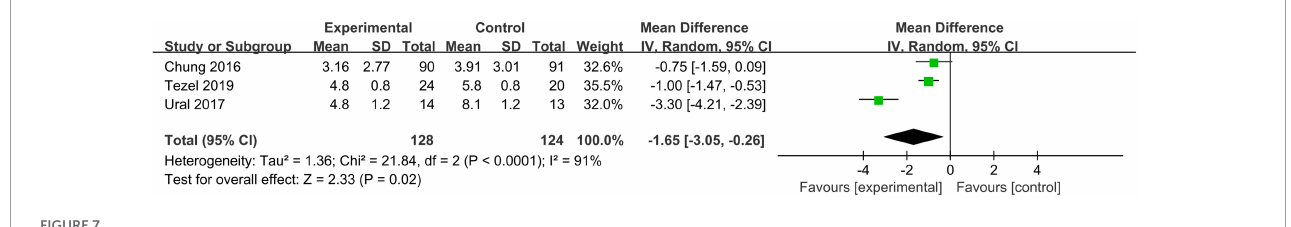
TABLE 2 The results of electrophysiological parameters for all comparisons. Comparison Experimental group vs. Outcomes Number of Intergroup differences Heterogeneity control group studies MD (95% CI)